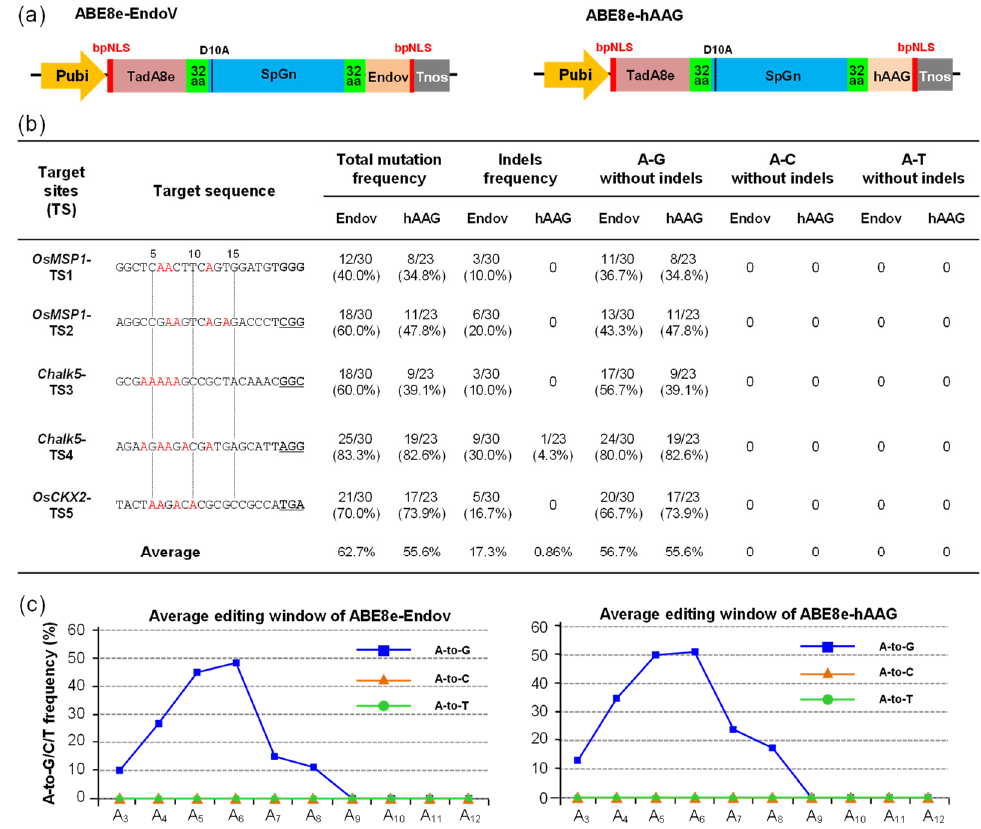
Figure 2. The editing efficiency and mutation type of ABE8e-EndoV and ABE8e-hAAG in T 0 rice. ( a ) Expression cassette structures of ABE8e-EndoV and ABE8e-hAAG. TadA8e, adenine deaminase with efficient A-to-G substitution; SpGn, an SpCas9 variant that recognizes NG-PAM and inactivates the cleavage activity of non-target strands; EndoV, E. coli endonuclease V, which works in the inosine alternative excision repair (AER) pathway, hydrolyzes the second phosphodiester bond located at 3 ′ to inosine in the DNA strand; hAAG, human alkyladenine DNA glycosylase, which works in the inosine BER pathway, removes inosine, and generates an apurinic/apyrimidinic (AP) site. ( b ) The efficiency and mutation type of ABE8e-EndoV and ABE8e-hAAG in T 0 rice, total mutations, and indel frequency were calculated by editing plant/total transgenic positive plants; for the A-to-G, A-to-C, and A-to-C substitutions, the base substitutions with indel alleles were eliminated. ( c ) Average editing windows and average editing efficiency of A-to-G/C/T substitution.